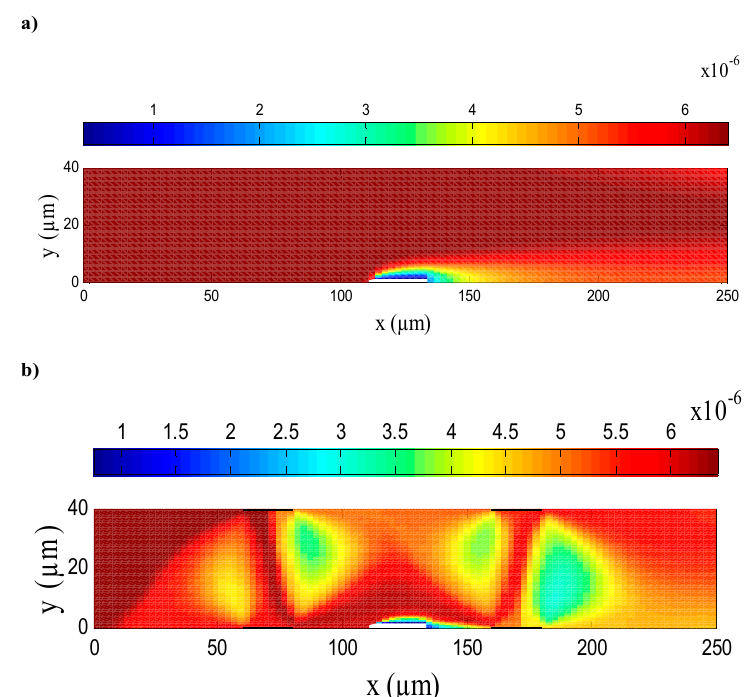
Figure 3. Analyte concentration distribution ( a ) in the absence of an electric field and ( b ) in the presence of an applied electric field.